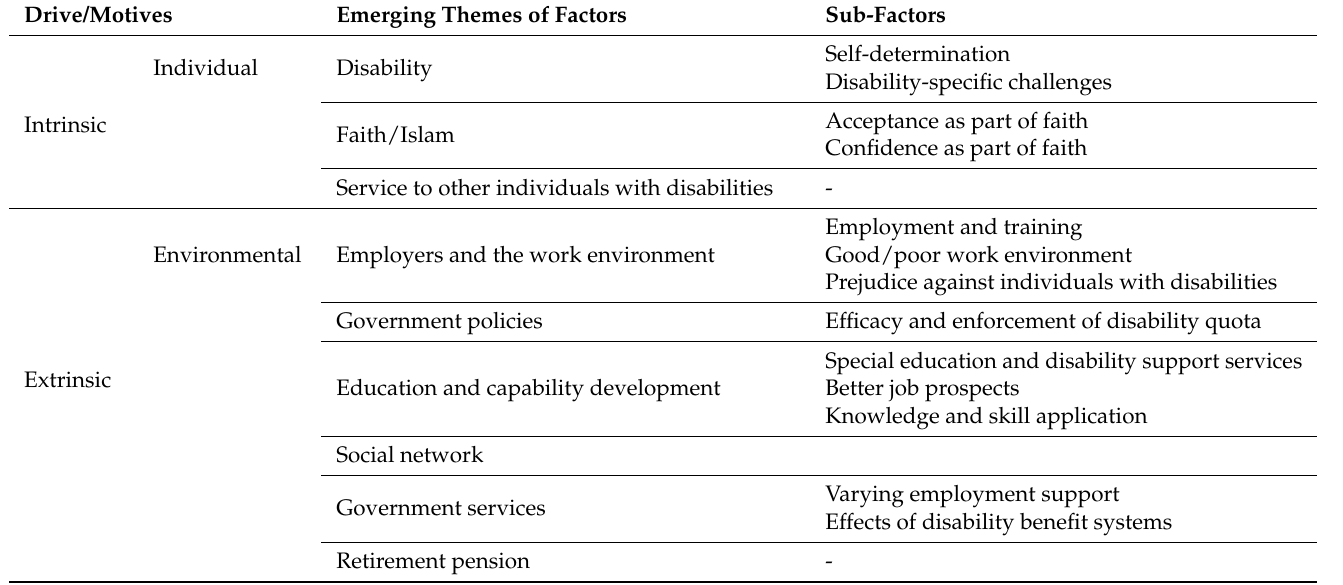
Table 3. Emerging themes of factors influencing individuals with disabilities in the